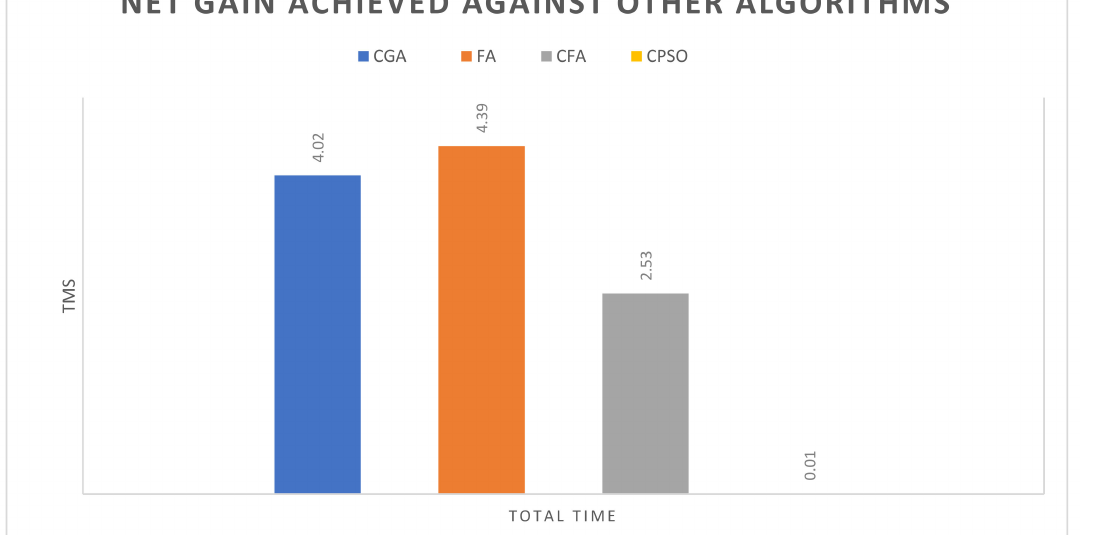
Figure 13. Comparison analysis of HPSO with other algorithm (Case 4).